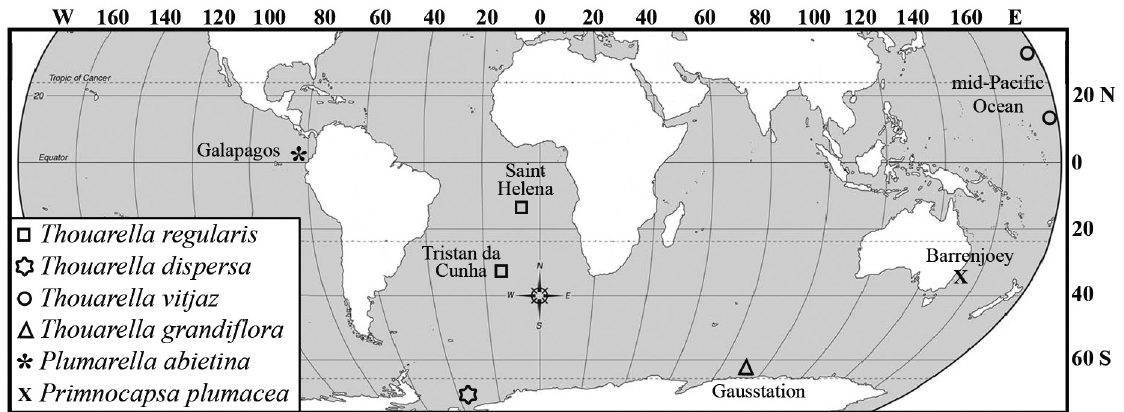
Fig . 1. – Known distribution of primnoid species studied in this paper: square, Thouarella regularis ; star, T. dispersa , Antarctica, no specific location; circle, T. vitjaz n. sp.; triangle, T. grandiflora ; asterisk, Plumarella ( Faxiella) abietina ; cross, Primnocapsa plumacea